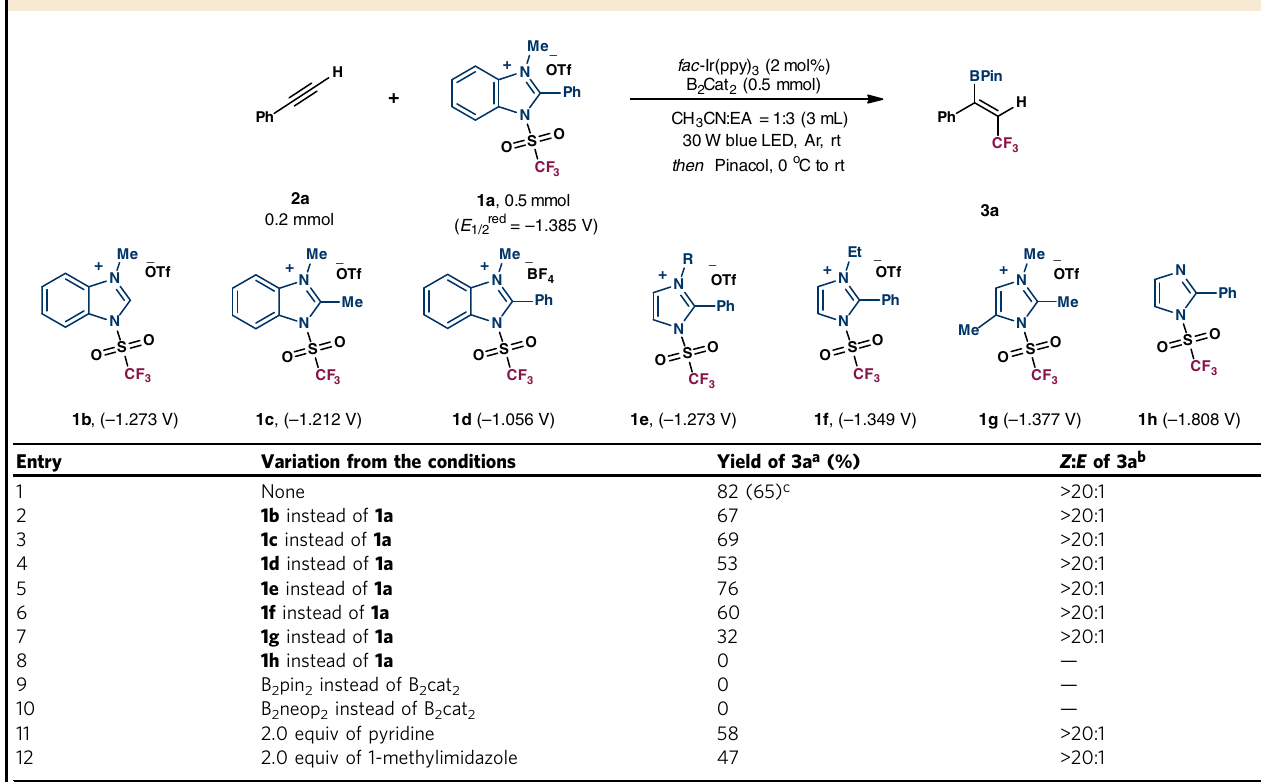
Table 1 Optimization of the reaction conditions.